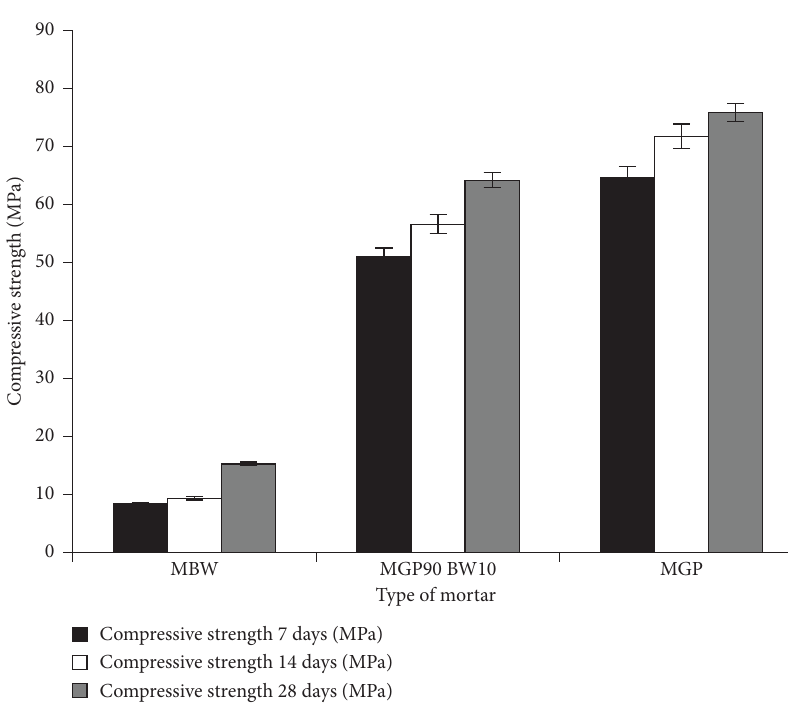
Figure 2: Compressive strengths of prepared geopolymer